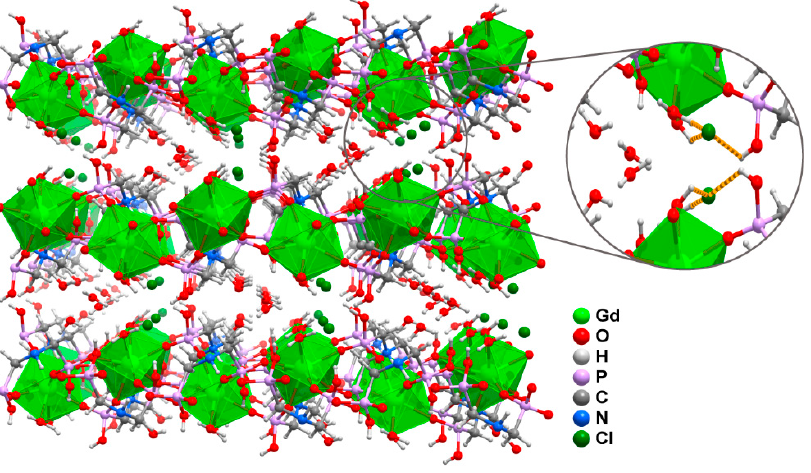
Figure 1. Structural representation of the positively charged crystalline coordination polymer [Gd(H 4 nmp)(H 2 O) 2 ]Cl·2H 2 O ( 1